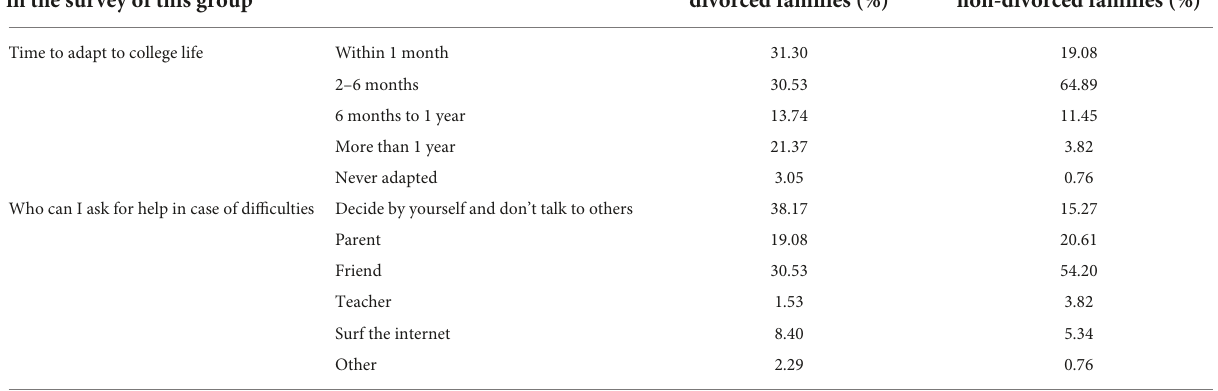
TABLE 5 Partial survey data of social